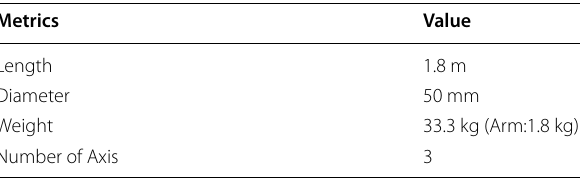
Table 2 Specification of the prototype bundled wire drive